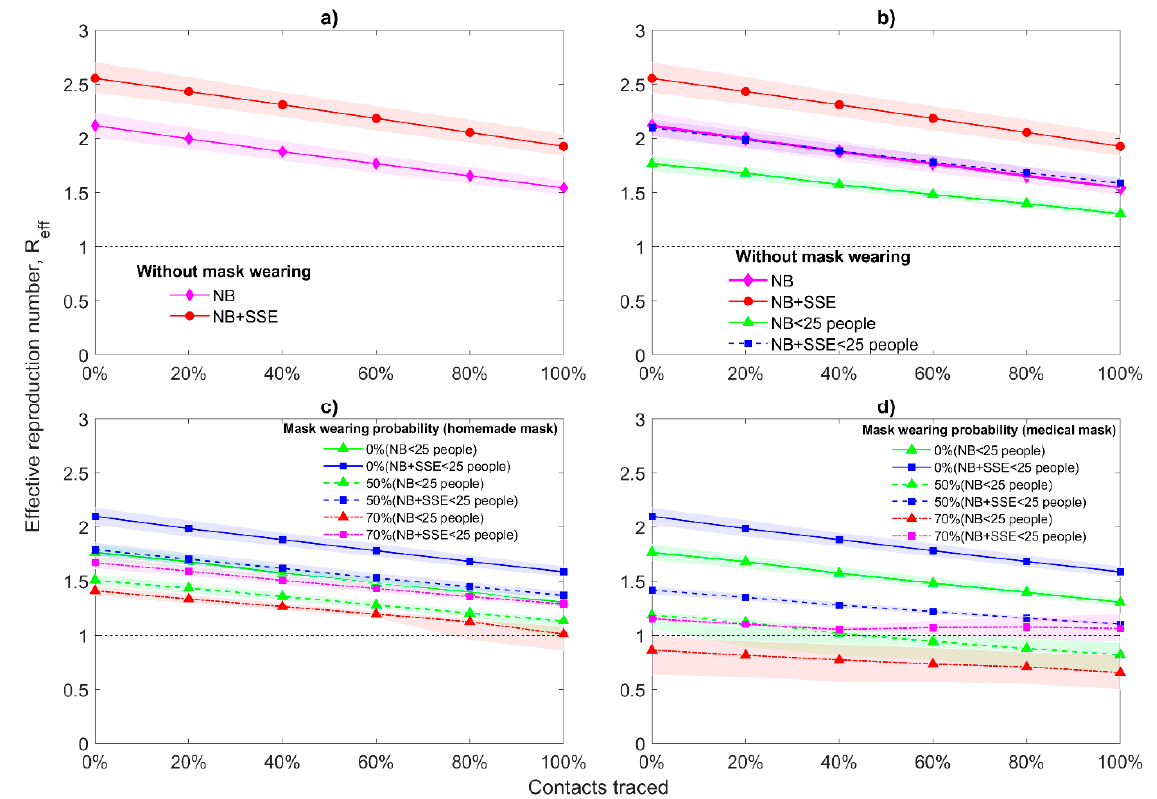
Figure 5. Median of effective reproduction number with interquartile range and superspreading events. R 0 = 2.5, R a = 1.875, 4 days of mean delay, 40% transmission before symptoms, initial number of symptomatic and asymptomatic cases is the same and equal to 20, all people wear masks, and the mask hinders spreading and protects from getting infected with different mask efficiency e m . Distributions used for secondary cases: negative binomial (NB), negative binomial with additional superspreading events (NB+SSE), negative binomial with restriction on maximum cases (NB < 25 people), negative binomial with additional superspreading events and restriction on maximum cases (NB + SSE < 25 people): ( a ) without mask wearing and SSEs; ( b ) without mask wearing but with SSEs; ( c ) e m = 20% (homemade mask); ( d ) e m = 50% (medical mask).